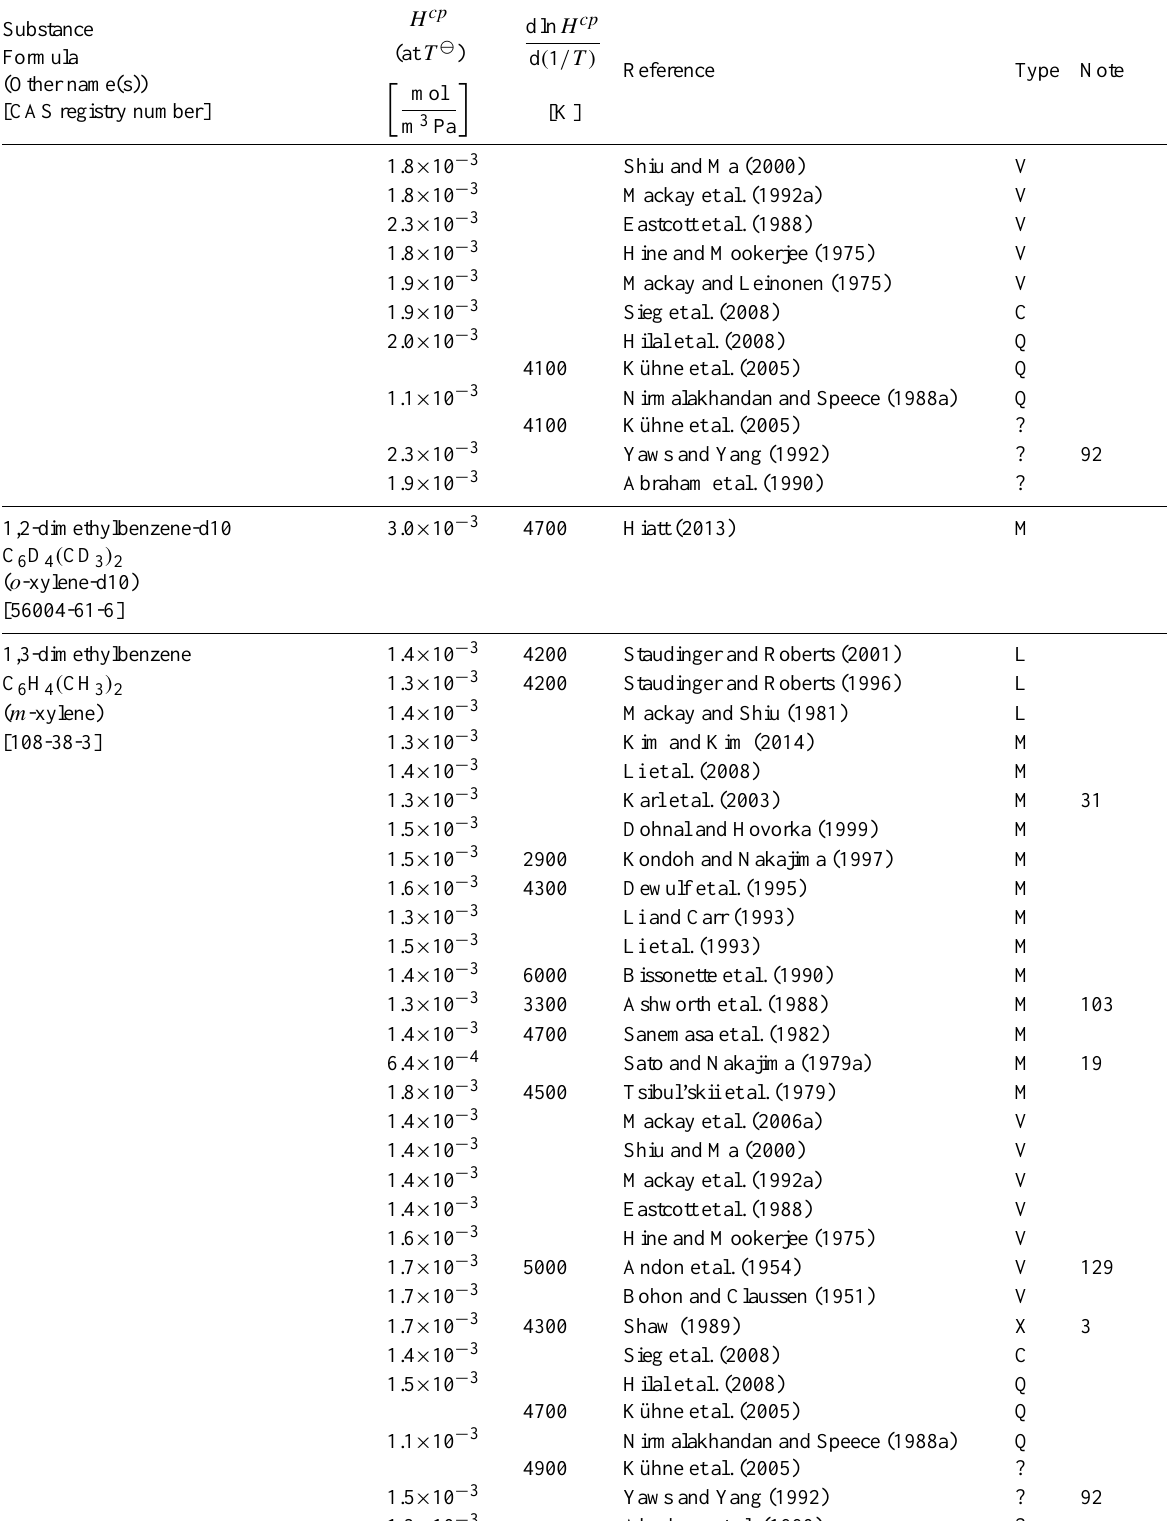
Table 6: Henry’s law constants for water as solvent